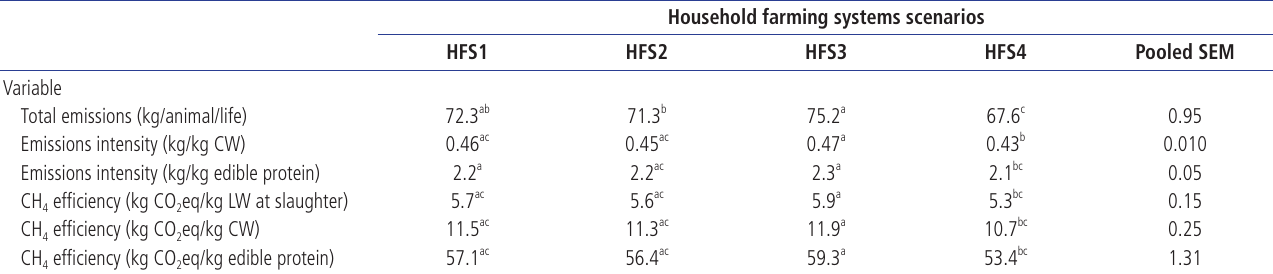
Table 2. A comparison of modelled methane emissions (CH ) 1) for four household farming systems (HFS) scenarios derived from the use of Yellow Local (Bos indicus)×Red Sindhi (Bos 4 indicus), and crossbred 1/2 Limousin, 1/2 Drought Master, and 1/2 Red Angus cattle records during a 3-month fattening period in the DakLak province of